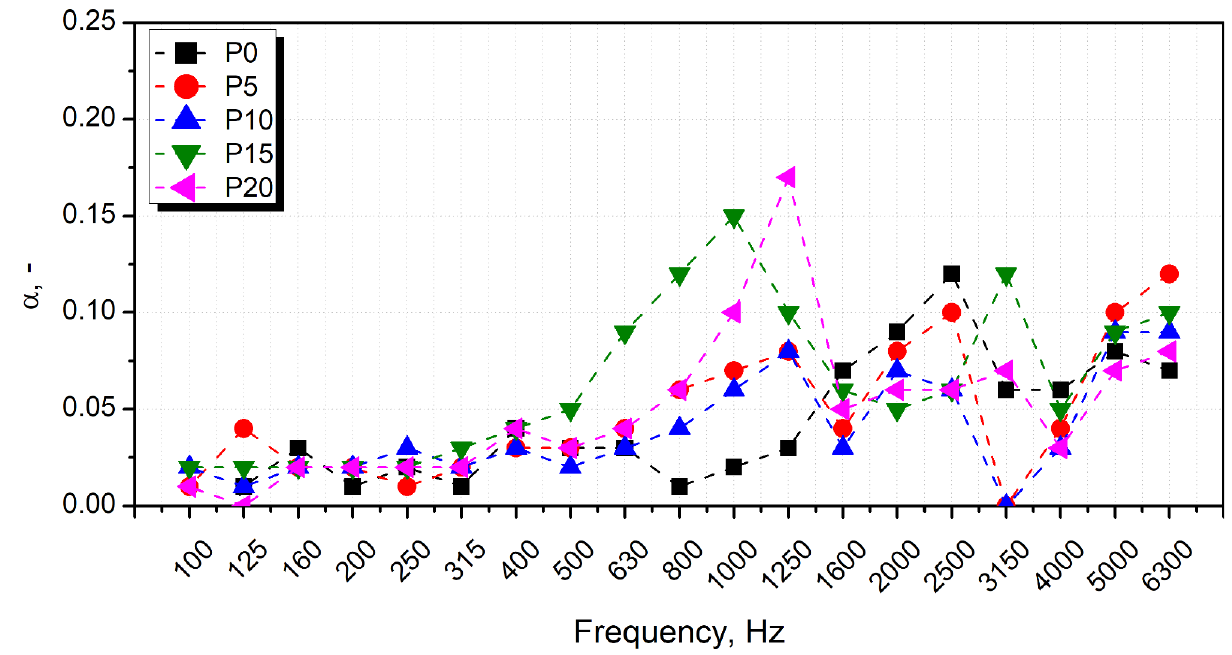
Figure 5. Sound absorption coefficient characteristics prepared samples in 1/3 octave bands (100 –